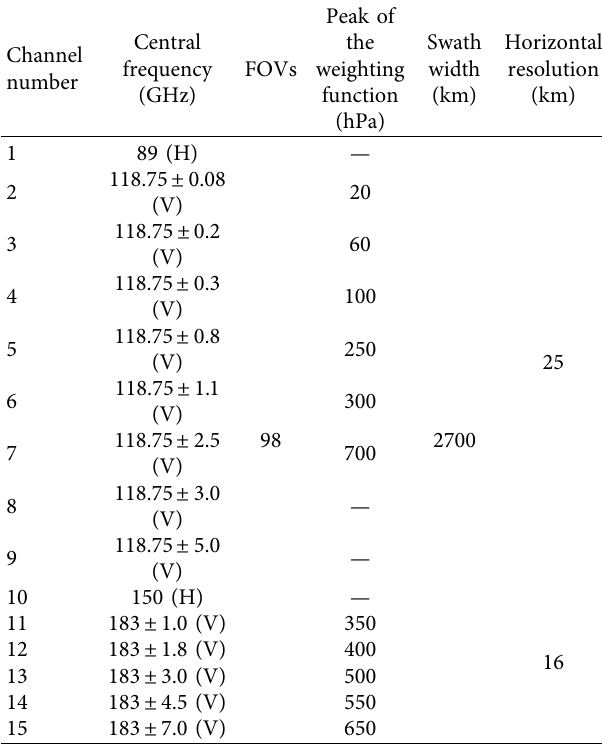
Table 1: The characteristics of MWHS-2/FY-3C.